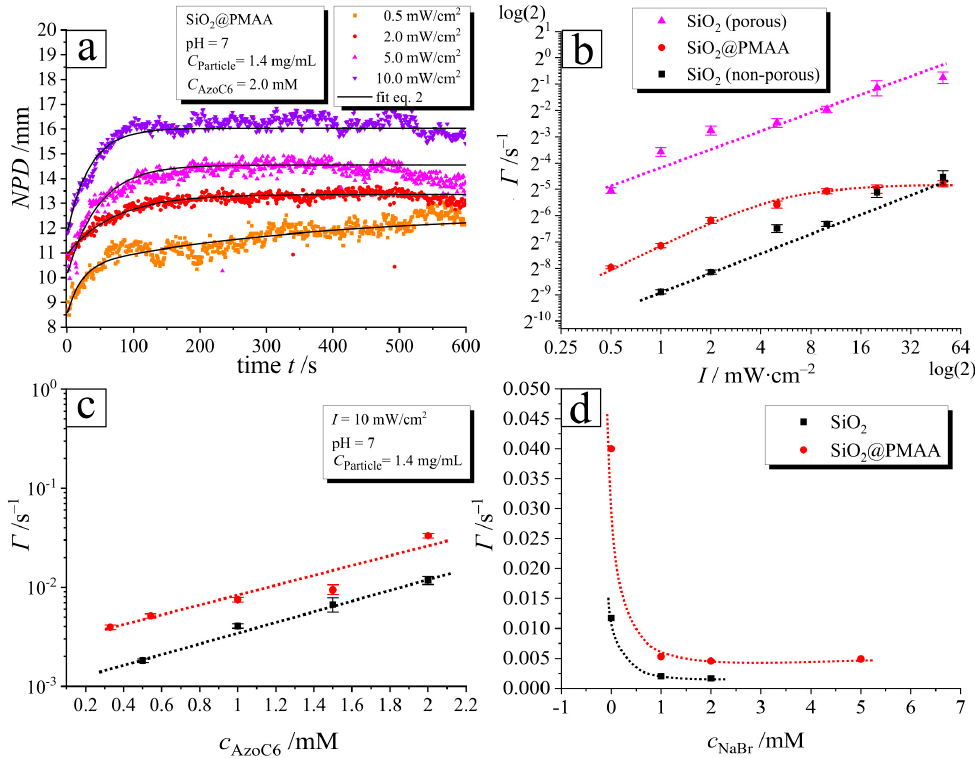
Figure 3. ( a ) Dependence of NPD on irradiation time ( λ = 455 nm, I = 10 mW/cm 2 , c azo = 2 mM) for